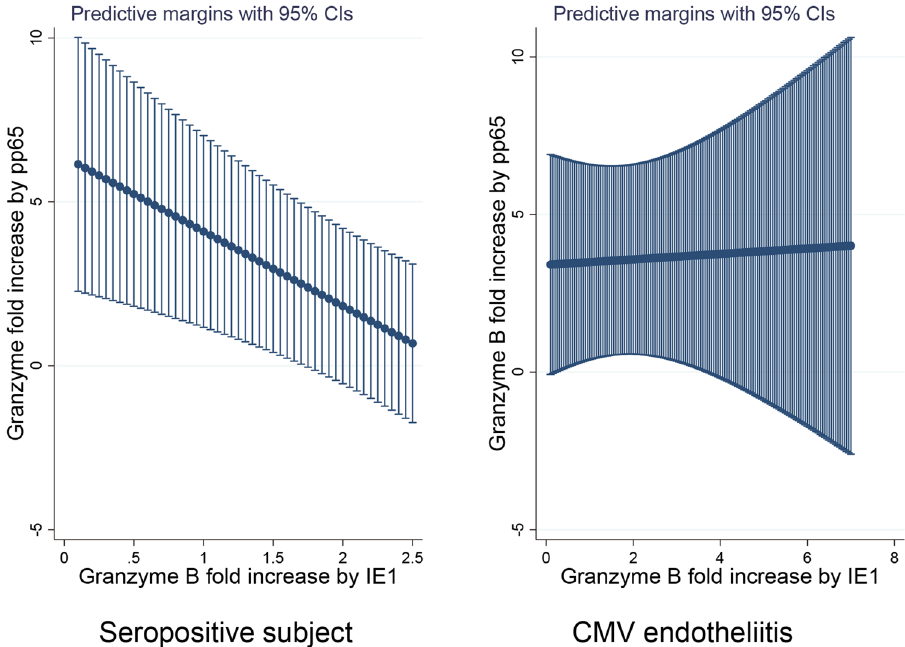
Figure 2. Reactivity profile of cytotoxic T lymphocyte (CTL) to cytomegalovirus (CMV) antigens in CMV endotheliitis and seropositive control subjects. The CTL activity was measured by the rate of increase of granzyme B against media as fold increases. The relationship of the induction of IE1 and pp65 specific CTL responses are calculated using linear regression analysis for CMV endotheliitis ( N = 9) and seropositive before onset subjects ( N = 6) after age adjustment. Seropositive subject showed higher pp65 CTL and low IE1 response ( P = 0.006, linear regression analysis). Endotheliitis patients were not changed for pp65 CTL response by the effect of IE1 CTL ( P =